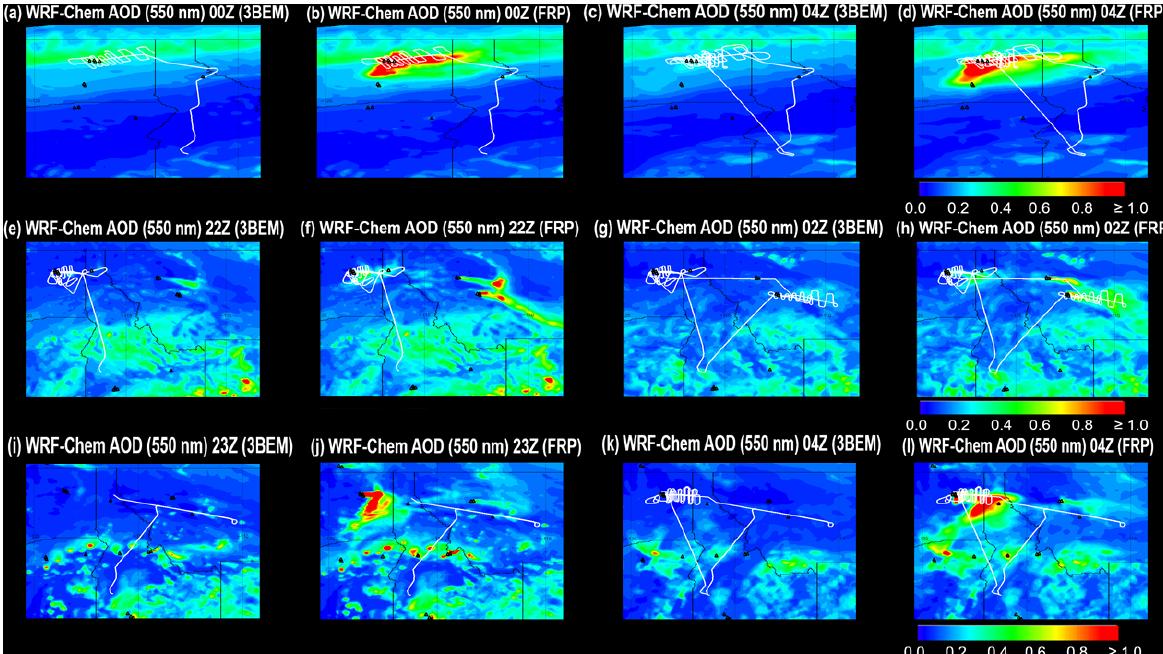
Figure 7. WRF-Chem-simulated aerosol optical depth (AOD) for the 3BEM and FRP versions during the FIREX-AQ DC-8 science flights on 3 August (a–d) , 6 August (e–h) , and 7 August (i–l) . The DC-8 flight track is overlaid. The triangle markers indicate the locations of active fires.